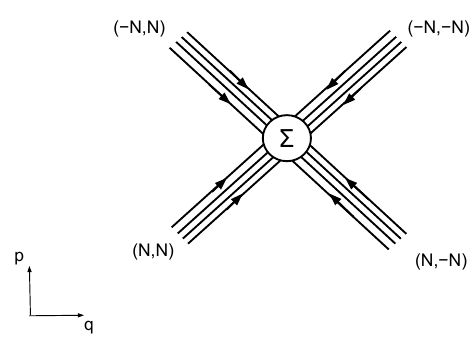
Figure 1 . The conformal limit of a brane web with four external ( p; q ) (cid:12)ve-branes and charge assignments of (3.8). Factors of 8 = 3 have been suppressed in labelling. The ( p; q ) are taken to have orientation inwards towards the vertex. The circle at the singular intersection point of the web represents the region where the supergravity solutions are expected to hold. When (cid:6) is taken to be the unit disc, it can roughly be thought of as being in the plane of the web and located at this center